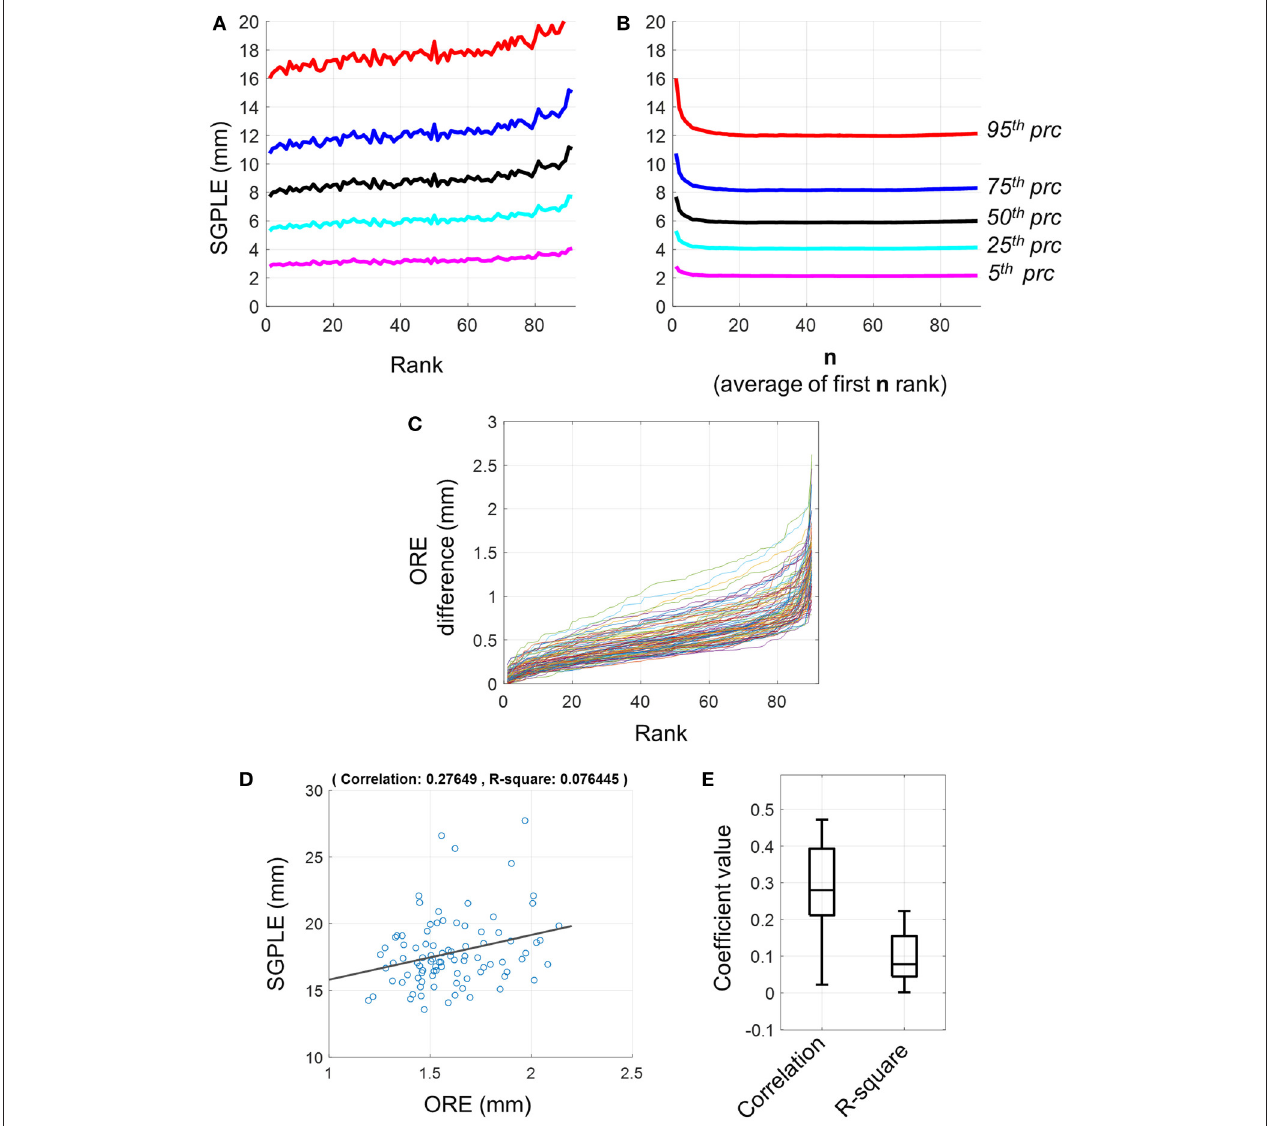
FIGURE 2 | Sourcemodel grid point location error (SGPLE) and objective registration error (ORE). (A) The meanSGPLE prc (Equation 7) for different rank of pseudo MRIs. (B) The meanSLE prc (Equation 7) for averaged rank pseudo MRIs. (C) Difference in ORE between first rank pseudo MRI and 2nd to 91st rank pseudo MRIs (x-axis). Each line represents the result for one subject. There were total 92 subjects. (D) Scatter plot with the linear regression line for SGPLE against ORE for each of 91 pseudo MRI (dots) for one representative subject. (E) Distribution of the correlation coefficient and linear regression R-square coefficient for association between ORE and SGPLE across the